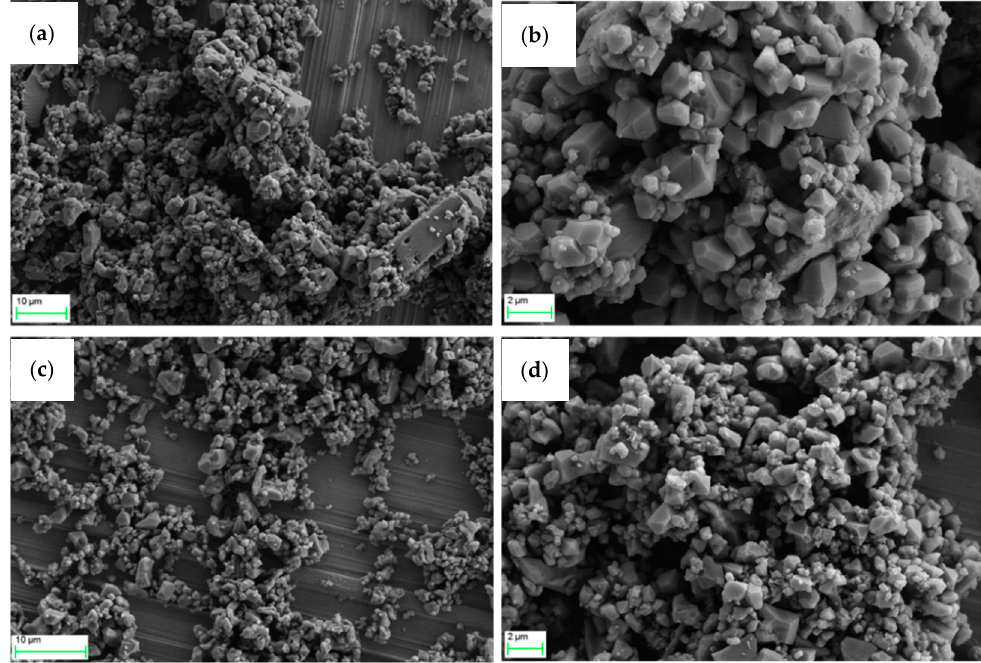
Figure 7. SEM images of the product from batch electrosynthesis ( a , b ), and electrosynthesis with flow processing ( c , d ). Both syntheses used a H 3 BTC concentration of 0.05 M.